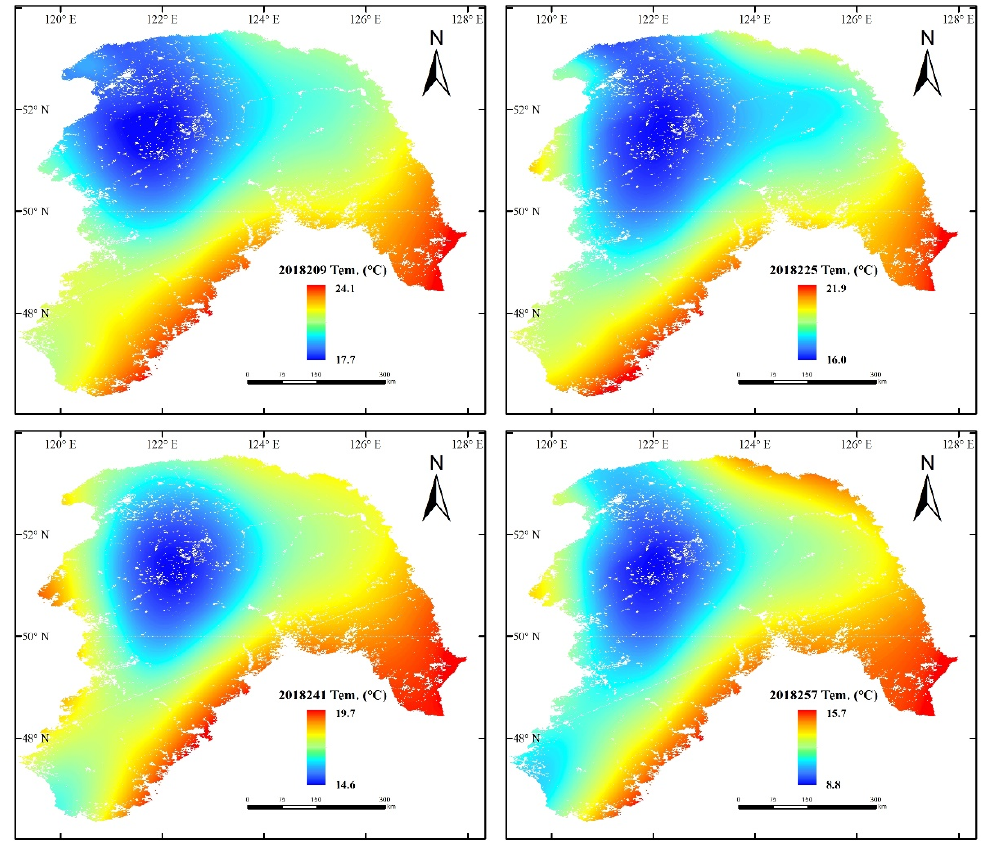
Figure 9. Kriging interpolation of 16 ‐ day mean temperature in 2015 and 2016. y = 0.10x ‐ 0.54 R² = 0.28